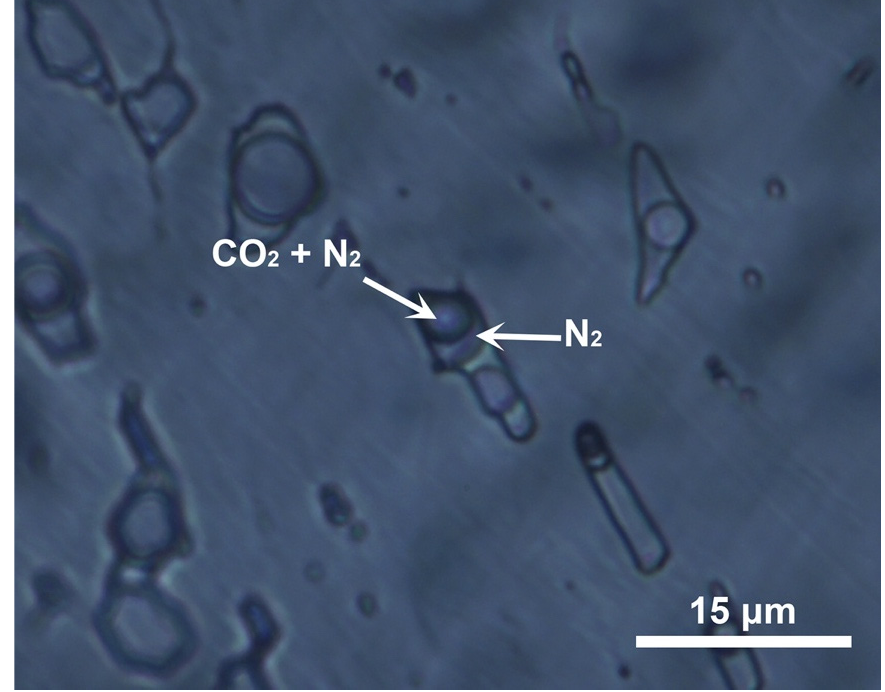
Figure 20. Minute tiny voids were observed filled with fluid inclusions.